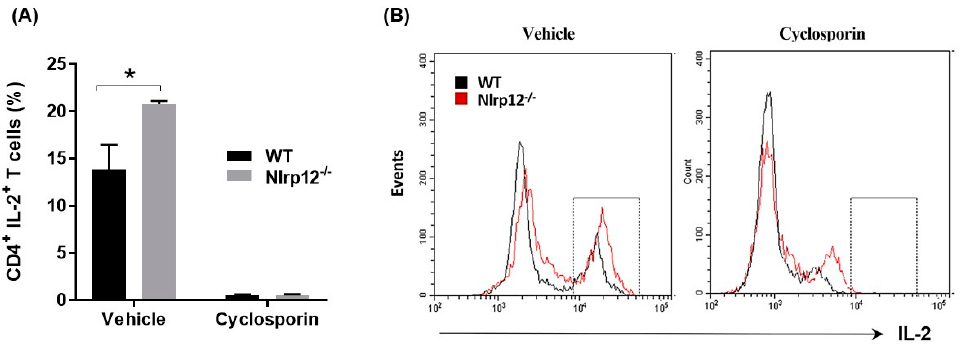
Figure 6. Nlrp12 inhibits IL-2 synthesis by activated T cells. ( A ) CD4 + T cells from WT and Nlrp12 − / − mice were activated with anti-CD3/CD28 for 24 h in the presence of cyclosporin or its vehicle (DMSO) for 24 h and intracellular expression of IL-2 were quantified using flow cytometry; ( B ) Representative flow cytometric histograms showing the population of IL-2 + T cells in vehicle or cyclosporin-treated group, n = 3, * p < 0.05.